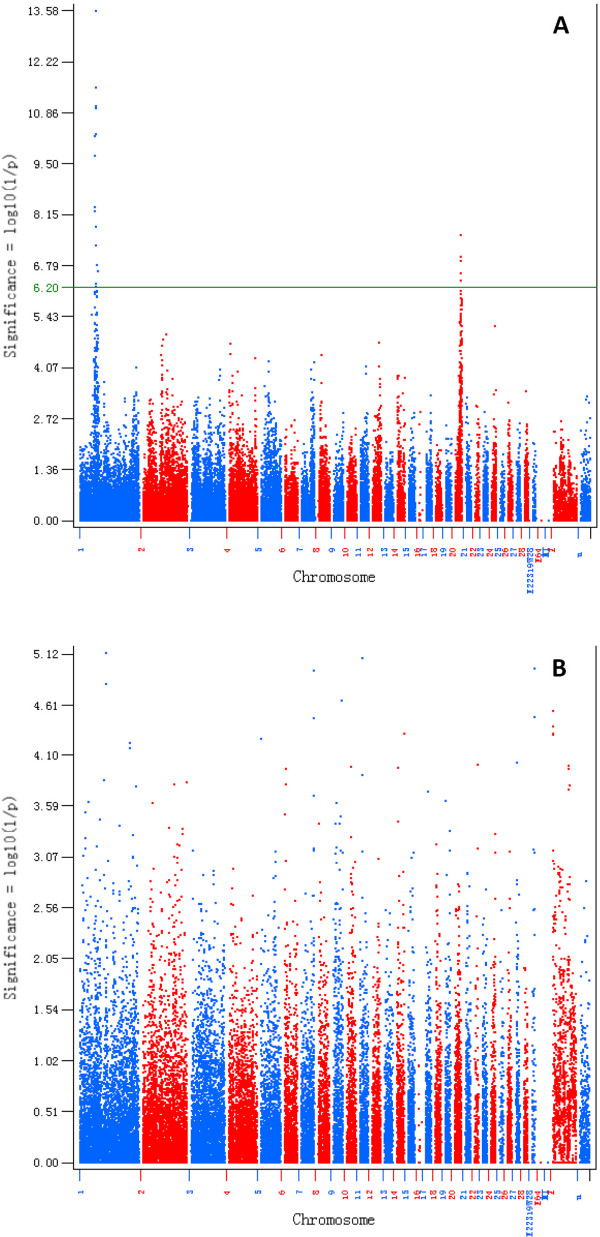
Manhattan plot of the genome-wide association study for the hyperpigmentation of visceral peritoneum (HVP) in chickens. The green line indicates the threshold P value of the 5% Bonferroni genome-wide significance (P = 6.28 × 10-7). A. Additive effects of GWAS for HVP. B. Dominance effects of GWAS for HVP.